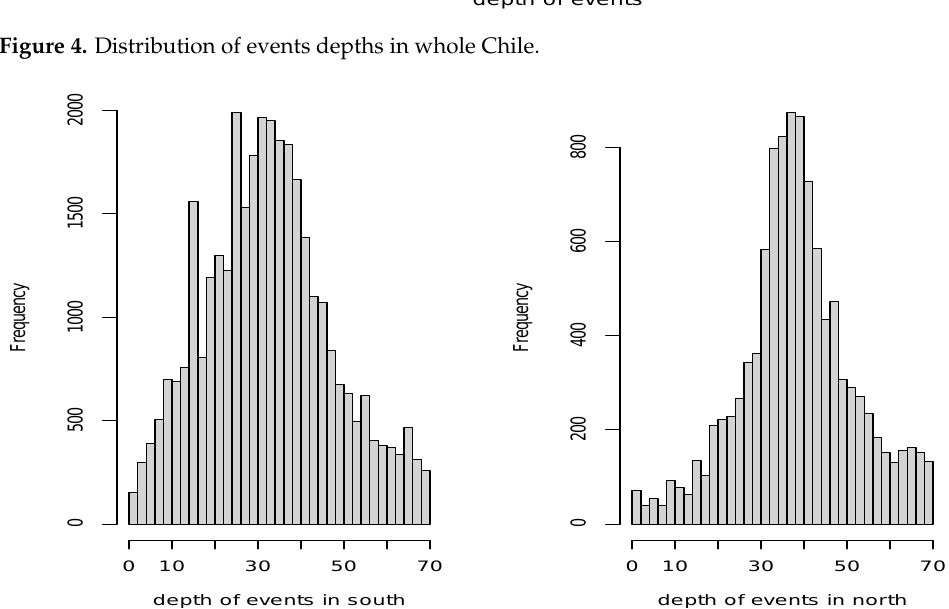
Figure 5. Distribution of depths of the selected events in the Southern and Northern